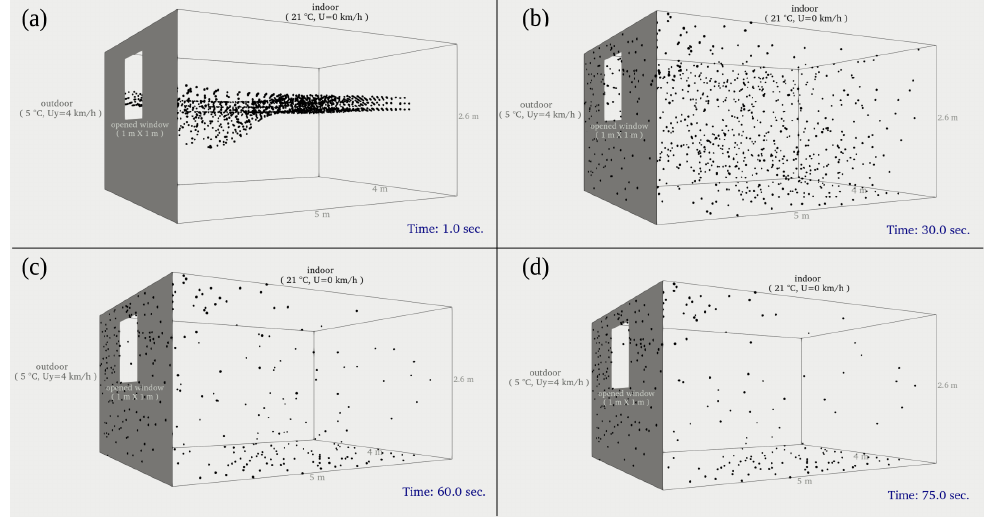
Figure 8. Local dispersion of aerosol particles indoor-outdoor. Case: Natural ventilation due to a low wind speed outdoors U y = 4 km/h and a lower outdoor temperature, walls-particles-interaction: stick . ( a ) t = 1 s showing the initially stratified layer of 3108 aerosol particles (0.15 µ m in diameter) placed between z = 1.5 m and z = 1.7 m; ( b ) t = 30 s; ( c ) t = 60 s; ( d ) t = 75 s. See the Supplementary Materials Video S3.